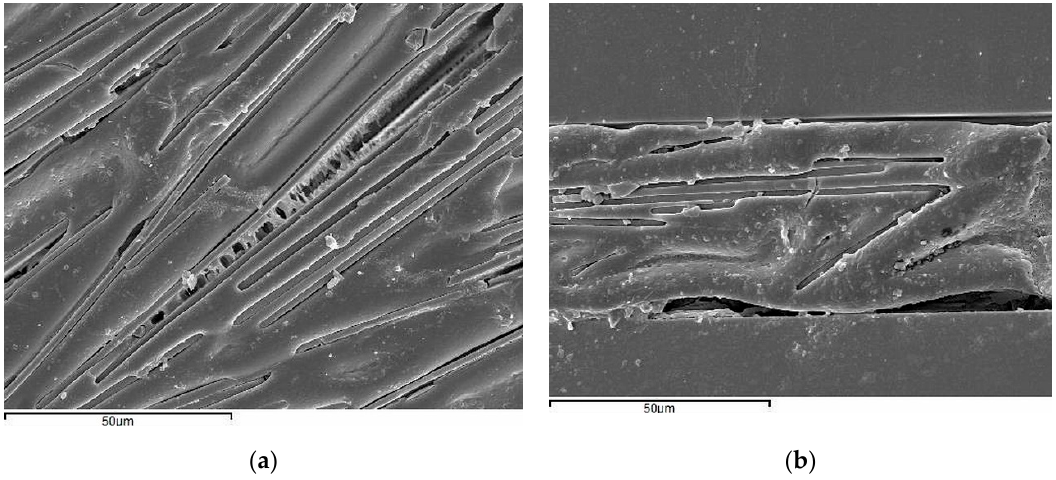
Figure 13. SEM (SEI) image using of PVB–MGF composites with 23 vol % ( a ) and 16 vol % ( b ) of GF100 ( d 50 = 160 µm) with slight delamination and preparation artefacts.